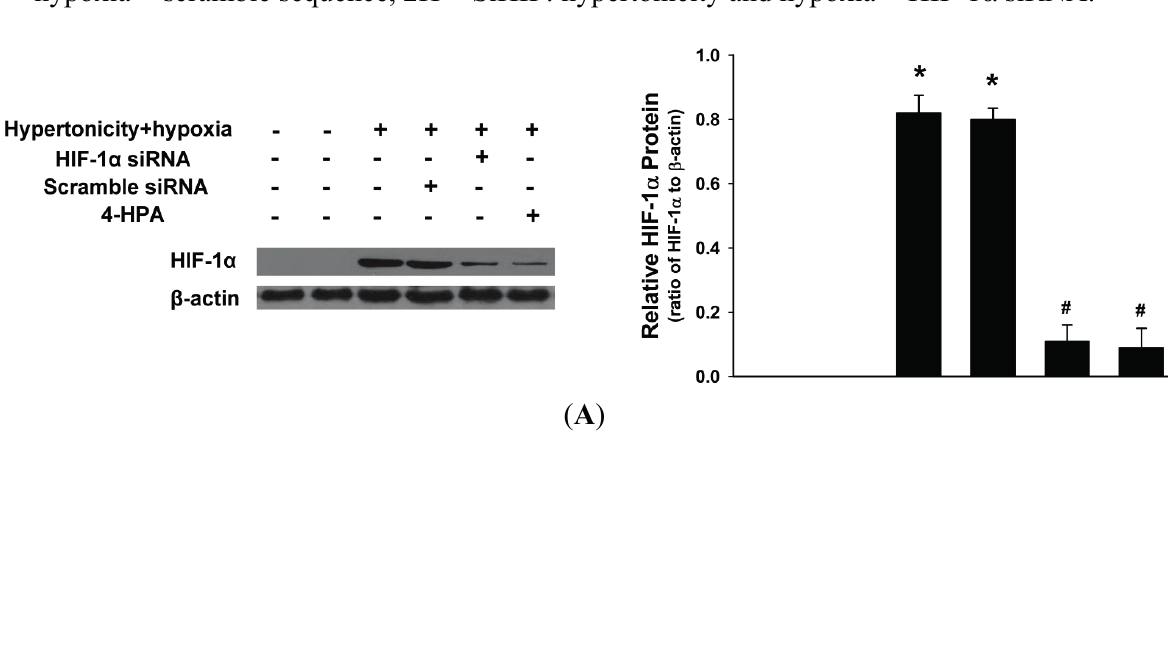
Figure 8. Effects of 4-HPA on inflammatory cytokines levels under hypertonicty